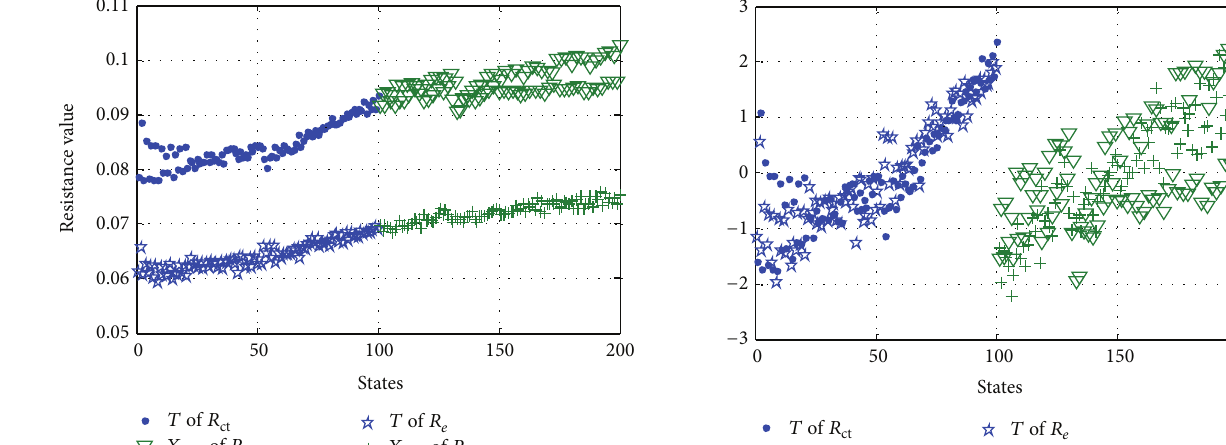
Figure 11: Training data 𝑇 and observation matrix 𝑋 𝑅 after normalization ct